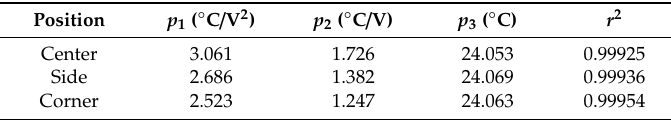
Table 2. Fitting parameters of heater